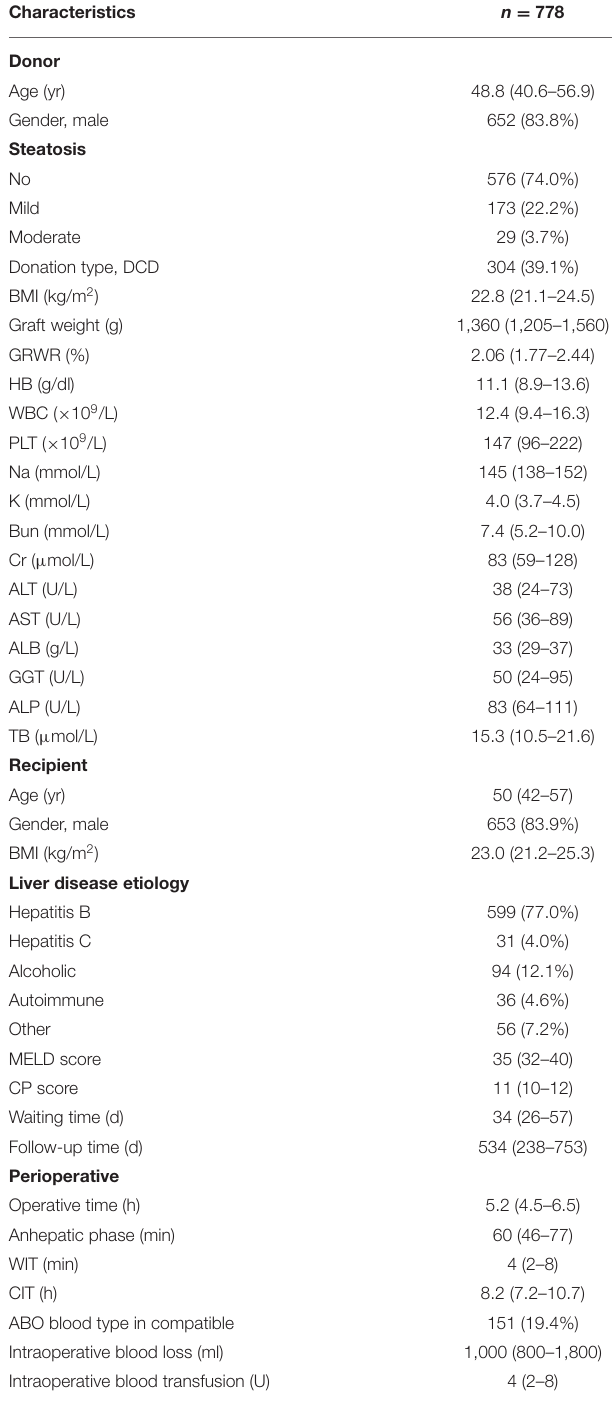
TABLE 1 | Baseline characteristics of donor and